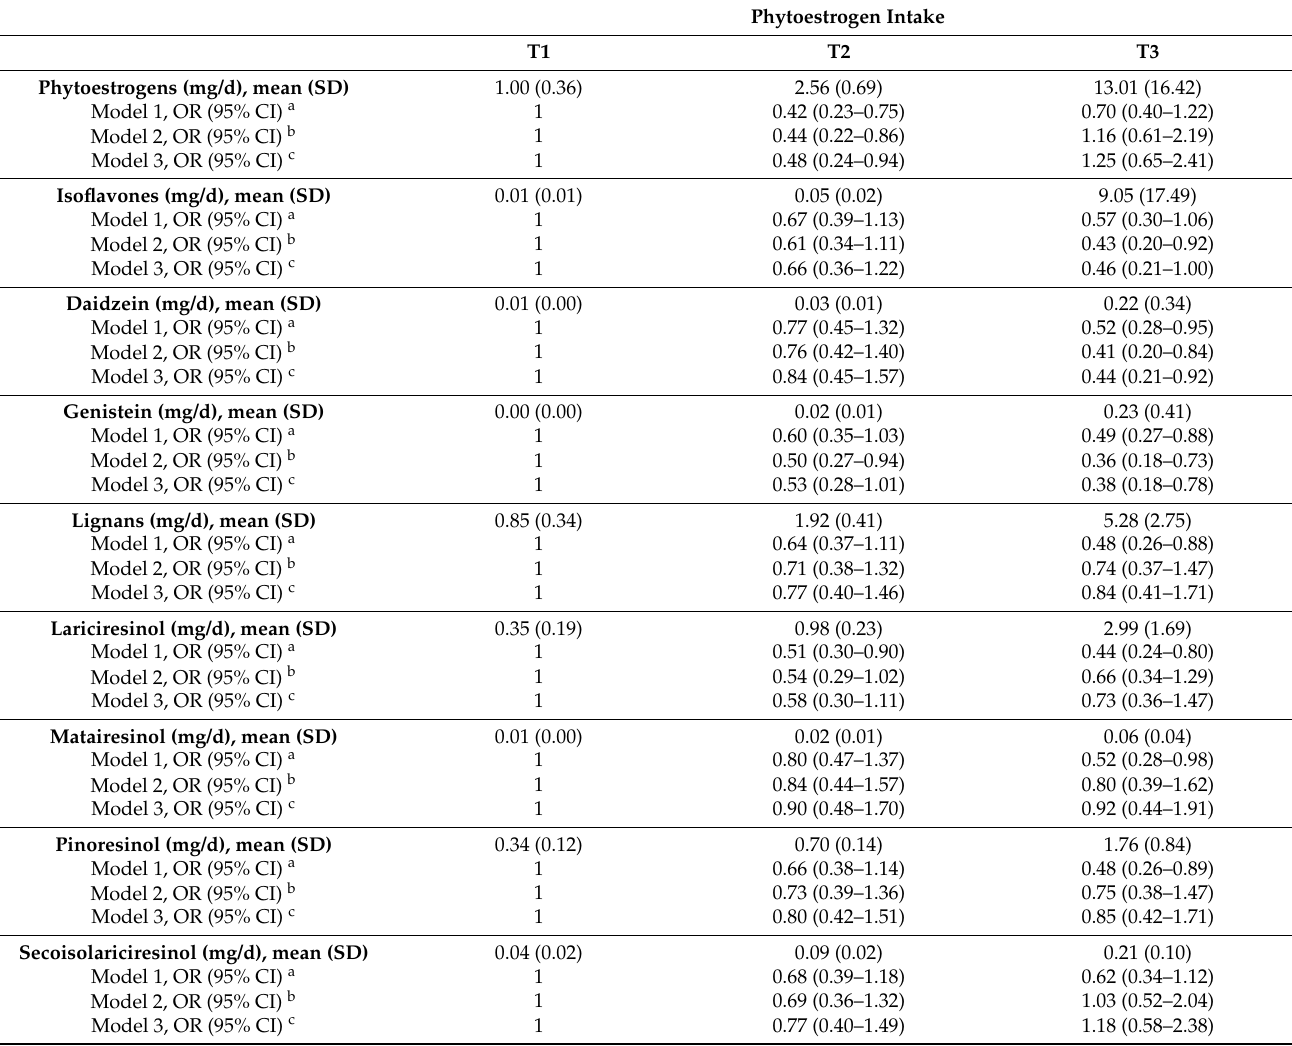
Table 3. Association between total and individual isoflavone and lignan intake, and impaired cognitive status. Phytoestrogen Intake T1